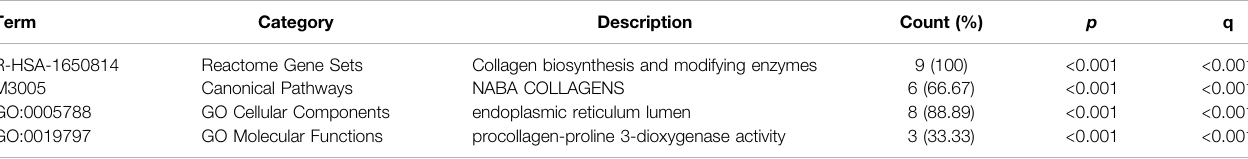
TABLE 5 | Clusters with their representative enriched terms (one per cluster).